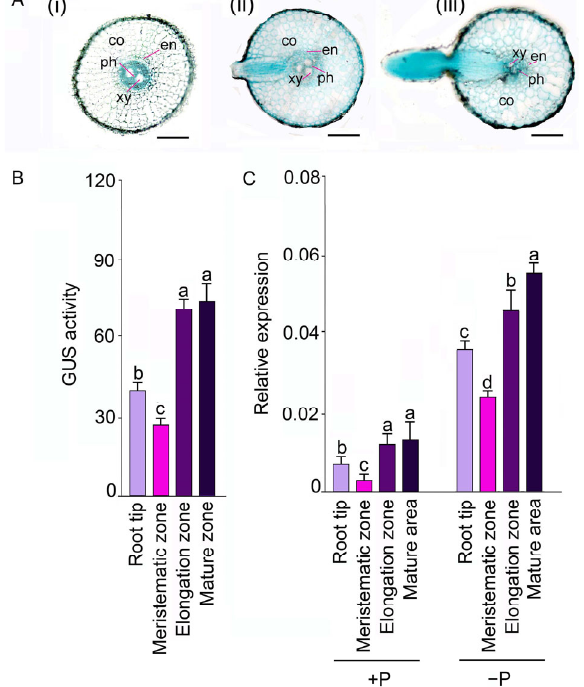
Figure 1. Expression pattern of OsSQD1 in rice roots. Histochemical analysis of the tissue-specific GUS staining ( A ) and activity ( B ) driven by OsSQD1 promoter (2028 bp upstream of its translation start codon). Cross-sections of OsSQD1 promoter-GUS fusion roots in ( A ) were meristematic zone (i), elongation zone (ii), and mature zone (iii) from left to right. co, en, xy, and ph refers to cortex, endodermis, xylem, and phloem, respectively. Bars represent 100 μ m. ( C ) The relative expression of OsSQD1 in root tip, meristematic zone, elongation zone, and mature zone of roots under different +P and − P conditions. Actin ( OsRac1 ; LOC_Os03g50885) was used as an internal control. Values ( B , C ) are means ± SE ( n = 3) and different letters on the histograms indicate that the values differ significantly ( p < 0.05, one ‐ way analysis of variance).